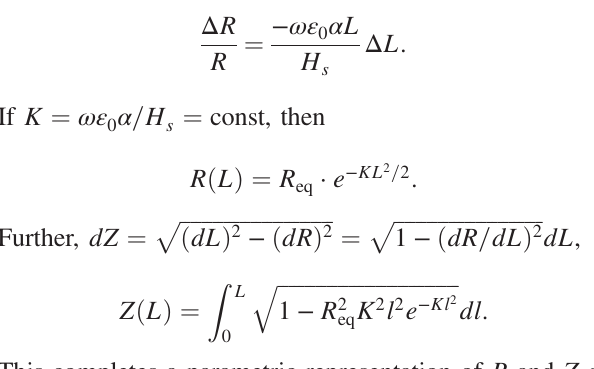
ffiffiffiffiffiffiffiffiffiffiffiffiffiffiffiffiffiffiffiffiffiffiffiffiffiffiffiffiffi p ffiffiffiffiffiffiffiffiffiffiffiffiffiffiffiffiffiffiffiffiffiffiffiffiffiffiffiffi p ð dL Þ 2 − ð dR Þ 2 1 − ð dR=dL Þ 2